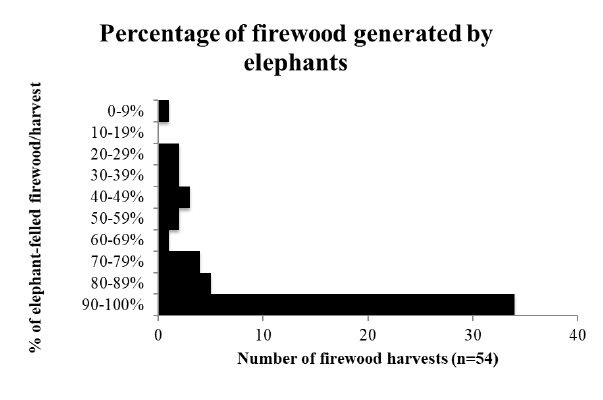
Fig. 2 . The percentage of firewood harvested from elephant- felled wood during firewood harvest focal